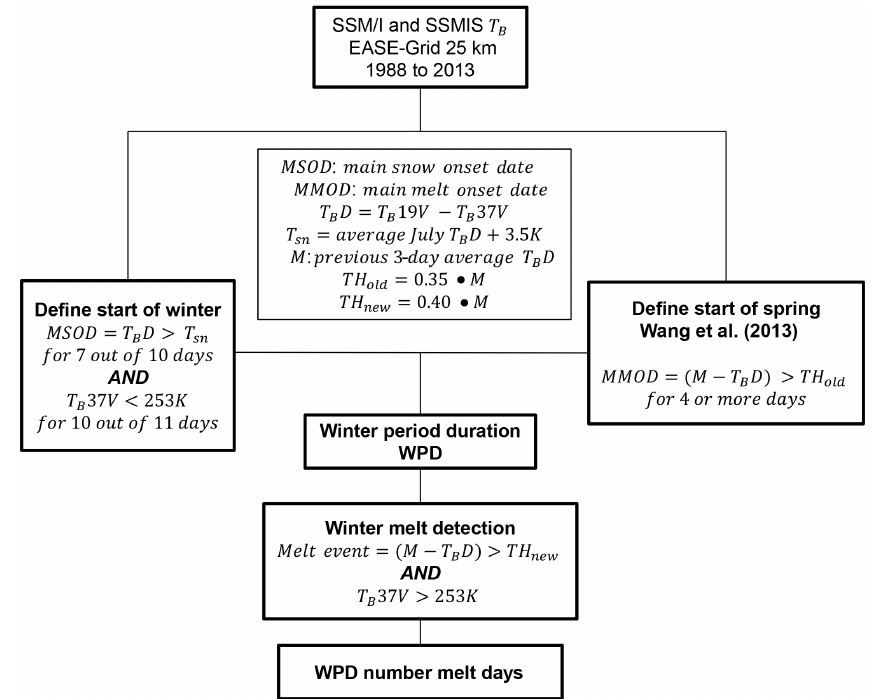
Figure 1. Schematic flow chart of the winter T B D melt detection method for PMW satellite data.